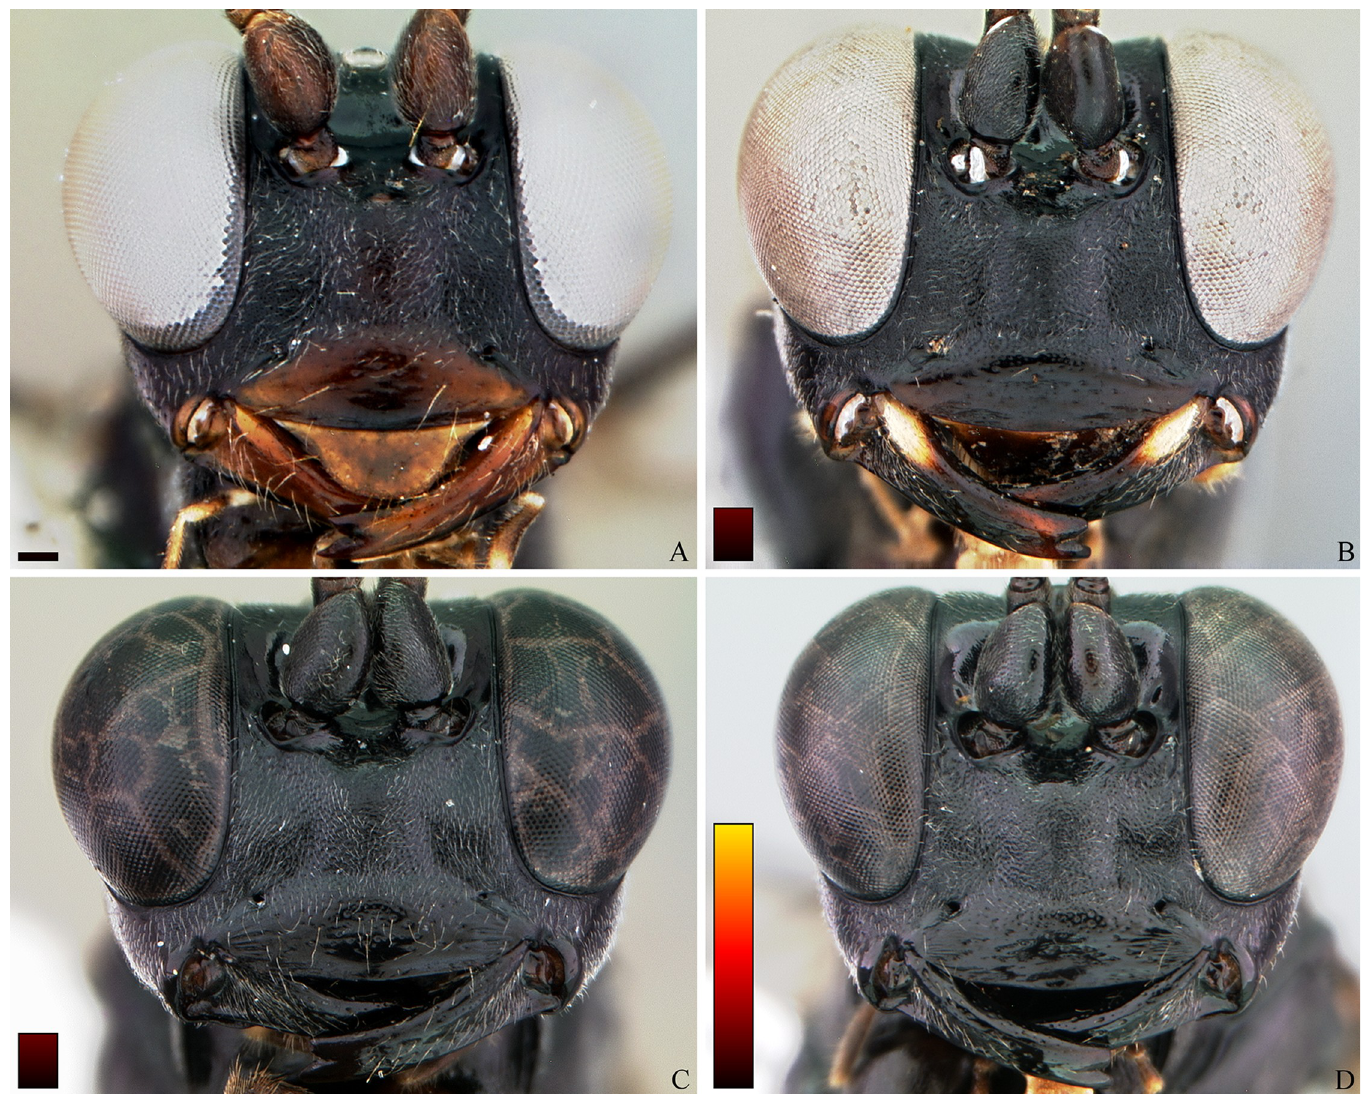
Fig 10. Cryptoxenodon metamorphus sp. nov. Female head in frontal view. (A) Paratype FAS4608, Alt. 16m, Brazil/PA. (B) Paratype FAS4601, Alt. 111m, Brazil/AM. (C) Paratype UFES45548, Alt. 115m, Brazil/BA. (D) Holotype FAS1127, Alt. 561m, Brazil/ES. Bars are proportional to the altitude. (Figs 11A and 14), about as long as second mid tarsomere. Ovipositor distinctly compressed, dorsal valve with nodus and pre-apical notch, ventral valve apex with few minute serrations (Fig 15D and 15E). Description. Body surface matte. HEAD. Clypeus outline in lateral view distinctly convex on basal half, apical portion truncate; clypeal margin medially convex, even if slightly, without teeth, laterally without projections. Mandible ventral margin not projected as a flange or crest; ventral tooth longer than dorsal tooth. Flagellum subapical width enlarged, distinctly greater than the rest of flagellum; apical flagellomere apex regular, uniformly tapered. Supra-antennal area outline strongly concave throughout, medially with a low, suture-like median longitudinal line; supra-antennal horns or tubercles absent. Gena ventrally from about as wide as at eye midlength to somewhat swollen, distinctly wider than at eye midlength. Vertex dorsomedial